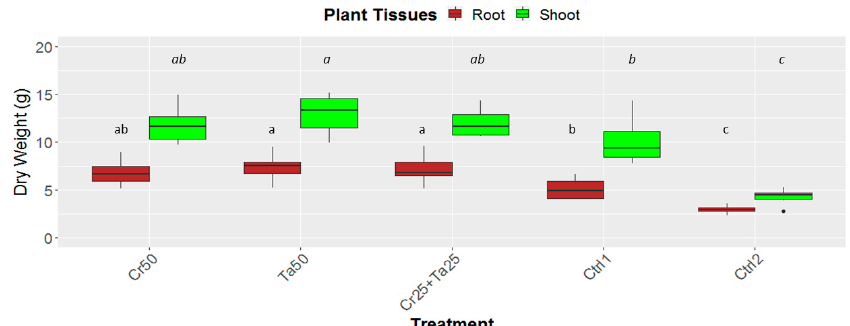
Figure 5. Effects of Ta and Cr , either applied individually or in consortium on the root and shoot dry weight of oil-palm seedlings at 5 months post-inoculation (MPI). Treatments abbreviations: Cr50—inoculated with 50 g of C. rosea AAB0114 ( Cr ); Ta50—inoculated with 50 g of T. apiculatus AAT0115 ( Ta ); Cr25 + Ta25—inoculated with 25 g of Cr and 25 g of Ta ; control 1—only the uninoculated blended maize was applied; and control 2—without the uninoculated blended maize. Means of the root and shoot dry weights were analyzed separately. Means with the same letters for the all five treatments the respective root and shoot dry weights were not significantly different with ANOVA–Fisher at p = 0.05. Microorganisms 2020 , 8 , x FOR PEER REVIEW